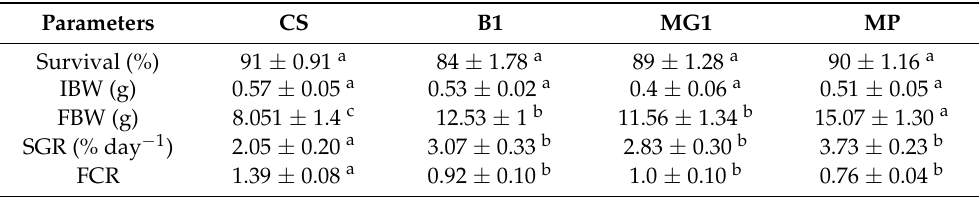
Table 4. Mean values ± SEM of the growth parameters of red hybrid tilapia fingerling cultured in biofloc system with addition of SPS11: Lysinibacillus fusiformis, L9: Bacillus amyloliquefaciens , LAB3: Enterococcus hirae , MP: Mixed probiotics (SPS11, L9, and LAB3), MG1: Commercial probiotics. Supercript a,b,c,d at different alphabetical letters indicate a statistically significant dif- ference (One-way ANOVA, p < 0.05).